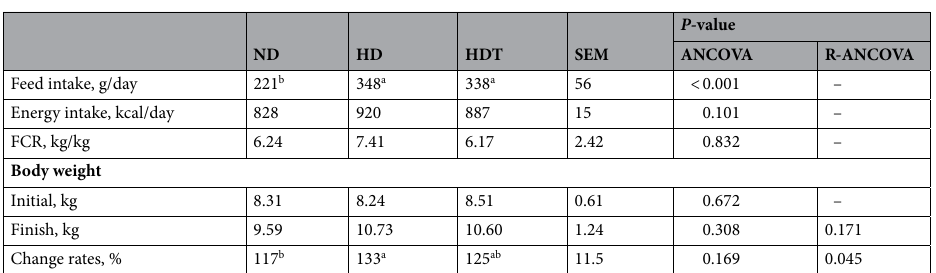
Table 3. Feed and energy intake and body weight. ND optimal energy intake + placebo, HD high energy intake + Placebo, HDT high energy intake + 100 mg·kg −1 ·day −1 BG + 100 mg·kg −1 ·day −1 SW; SEM standard error mean, ANCOVA analysis of covariance, R- ANCOVA repeated-ANCOVA, FCR feed conversion rate, BCS body condition score. a,b Data without same superscript in a row significantly differ (P < 0.05).